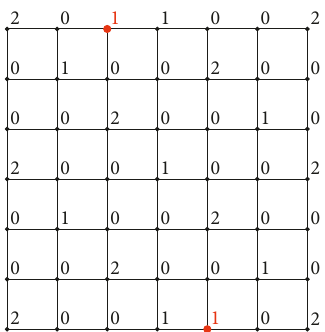
Figure 5: The function f